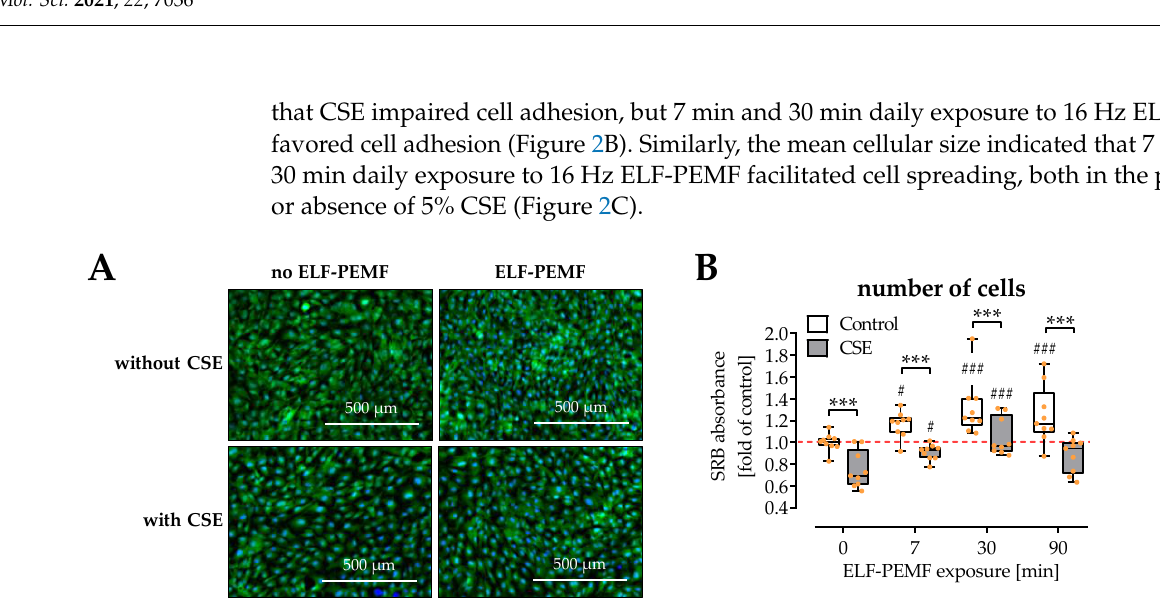
Figure 1. SCP-1 cell viability is affected by 16 Hz ELF-PEMFs (0, 7, 30, and 90 min) and 5% cigarette smoke extract (CSE). ( A ) Fluorescent Calcein-AM staining (2 µM, green) was used to visualize living cells, and Hoechst 33,342 (2 μg/mL, blue) was used as nuclear counterstain. ( B ) Sulforhodamine B (SRB) staining was used to quantify cell numbers by total protein content after 3 days. N = 3, n = 3. Data are presented as a box plot (Min to Max with single data points). Data were compared by non-parametric two-way ANOVA followed by Tukey’s multiple comparison test: *** p < 0.001 as indicated; # p < 0.05 ### p < 0.001 as compared to the respective control (no ELF-PEMF).